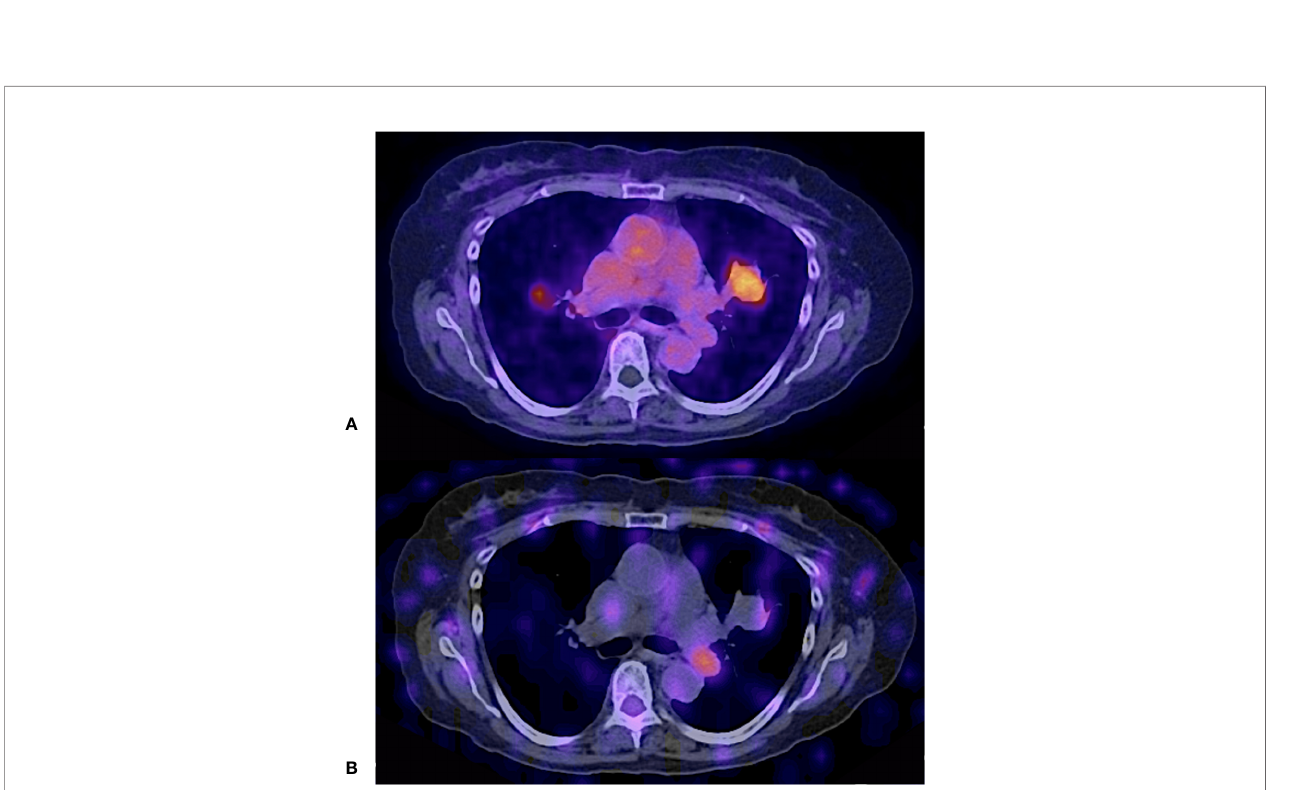
FIGURE 8 | 65 years old female; Thyroglobulin 253 ng/dl; treated with TT+RAI (14800 MBq). First two images show an 131 I – post therapy whole body scan in (A) anterior and (B) posterior projections, with a star – shapped intense uptake. The image on the right (C) , shows 68 Ga – PSMA PET/CT maximum intensity projection [MIP], which manifests a glaring superiority regarding spacial resolution, and target – to – background ratio.